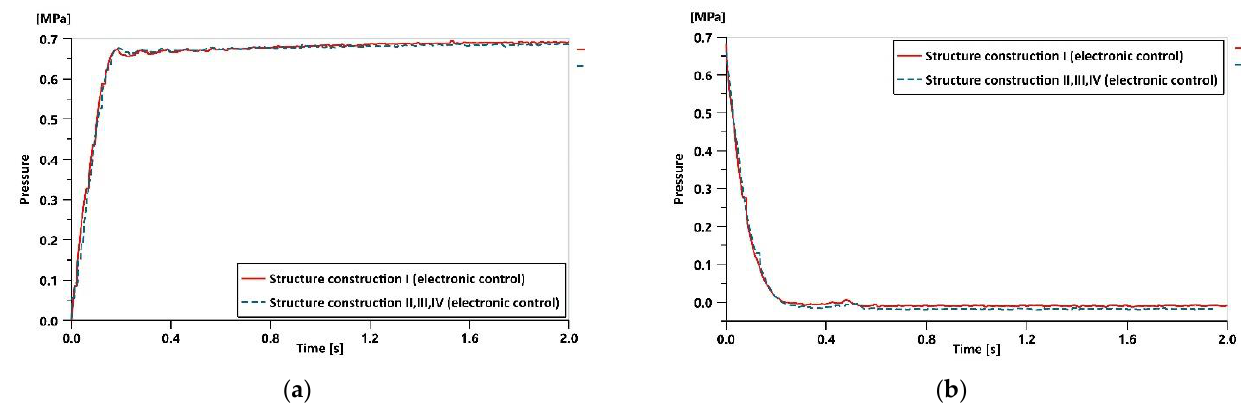
Figure 9. Test results of the pressurization–decompression test under electronic control: ( a ) pressurization test and ( b ) decompression test.